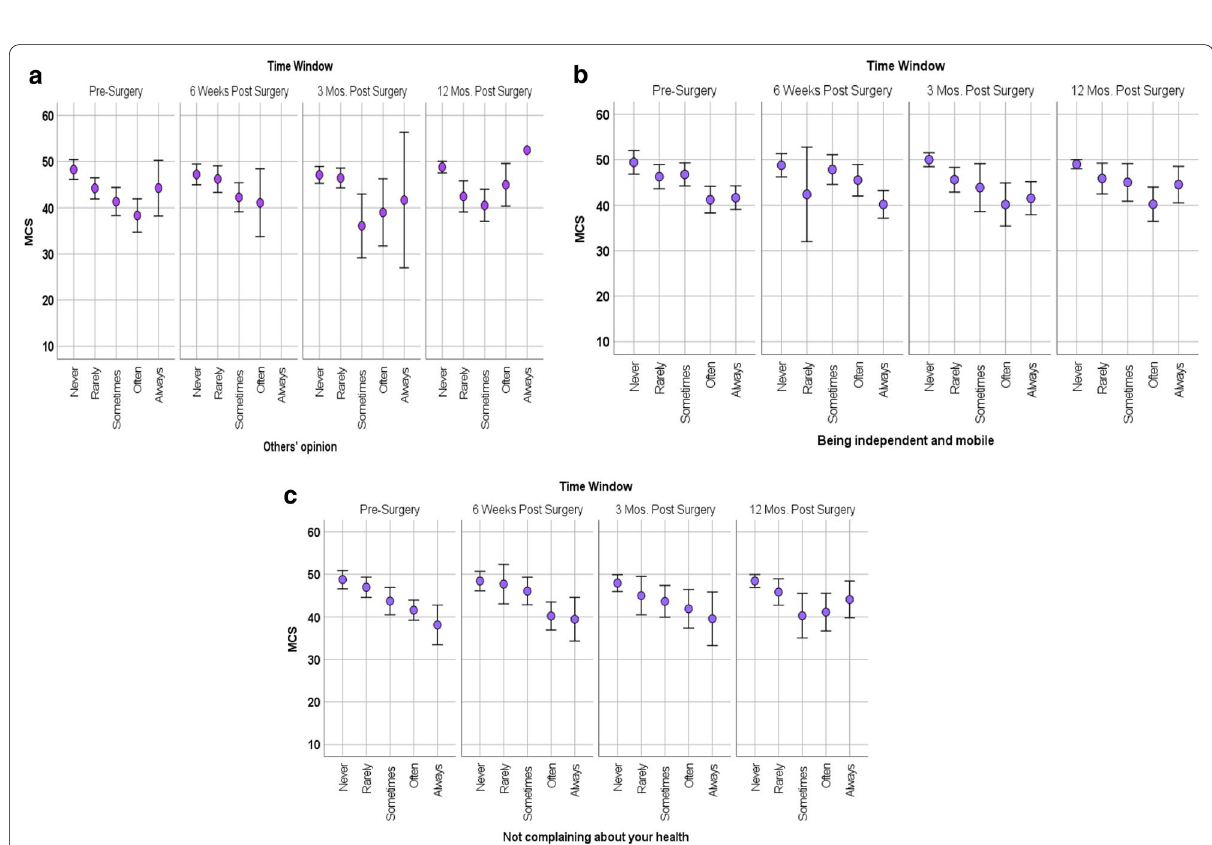
Fig. 5 a – c Interactions of appraisal with MCS over